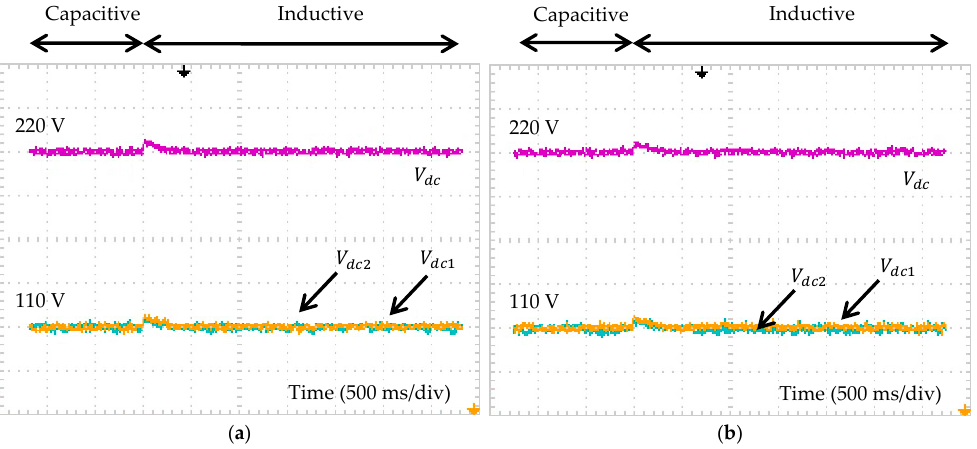
Figure 12. Experimental result showing the overall dc-link voltage V dc (20 V/div) and individual capacitor voltages V dc 1 (10 V/div) and V dc 2 (10 V/div), demonstrated by SAPF while applying: ( a ) the proposed algorithm; and ( b ) the existing algorithm, for dynamic-state condition of capacitive to inductive loads.